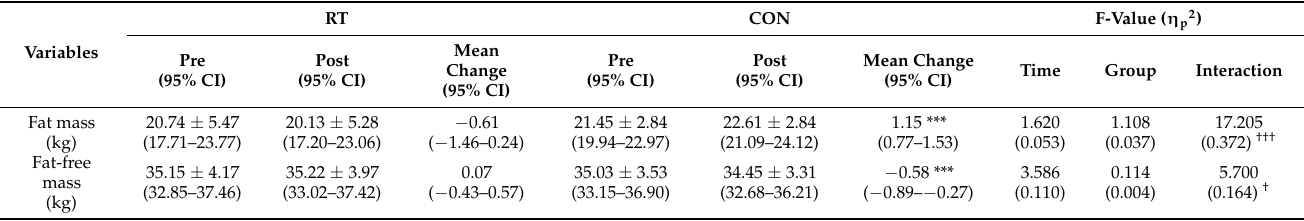
Table 3. Changes of body composition and BMD between pre- and post-tests in obese older women. RT CON F-Value ( η p2 ) Variables Pre (95% CI) Interaction Fat mass (kg) Fat-free